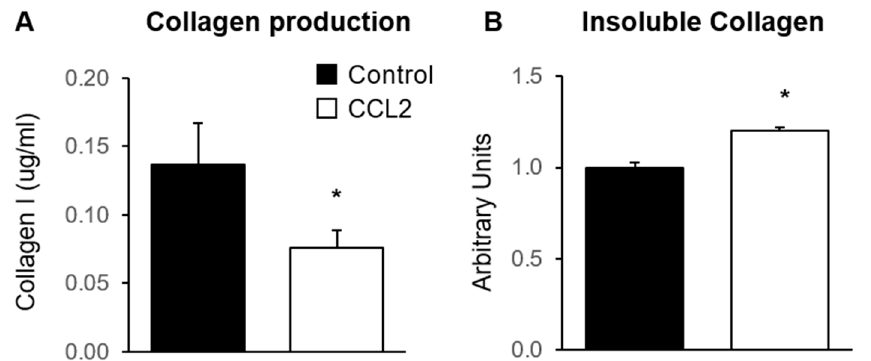
Figure 3. The effect of CCL2 on collagen production by mammary fibroblasts. Primary mammary fibroblasts were cultured alone (Control) or with 500 ng/mL of CCL2 for 72 h. Collagen was measured using collagen 1 ELISA that detects soluble collagen ( A ) and insoluable collagen was measured by Sirius Red staining ( B ). All data are presented as mean + SEM. Statistical analysis was performed using a linear mixed effects model with Tukey’s post hoc comparison. Statistical significance is indicated by * when p < 0.05.